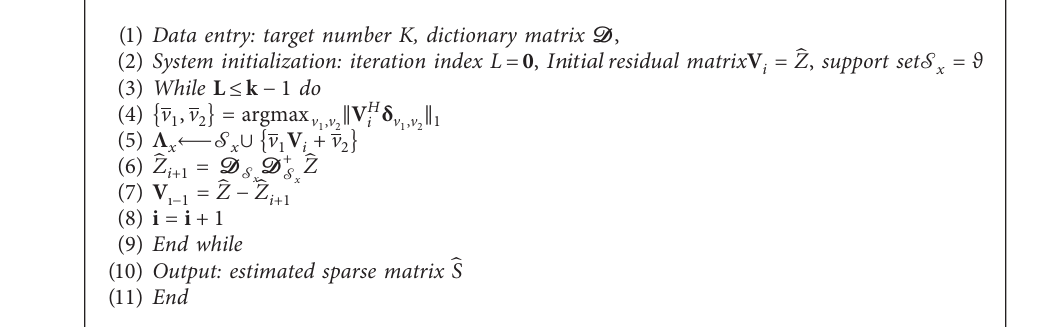
A LGORITHM 2: SOMP algorithm for angle